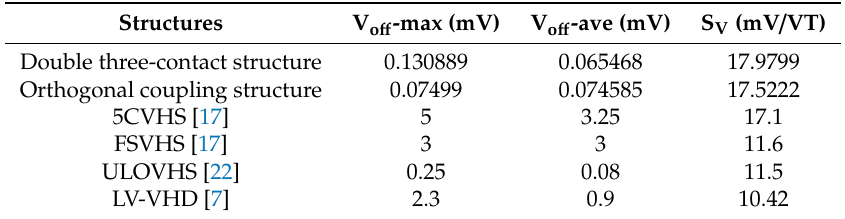
Table 3. Performance comparison between di ff erent vertical Hall